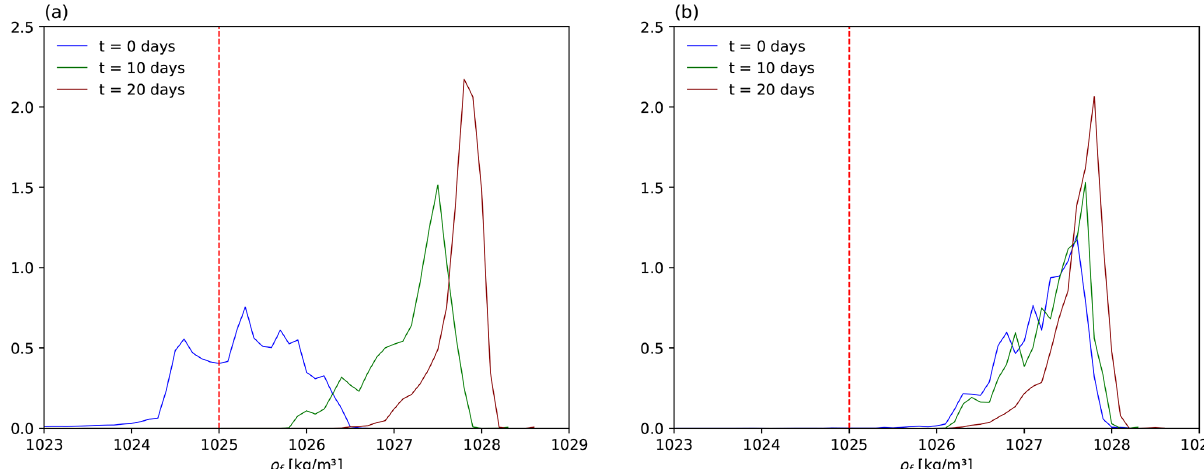
Figure 3. Normalized histogram of the seawater density ρ f at the positions of N = 78803 particles after t = 0, 10, and 20d of being released over the whole Mediterranean. (a) Summer release (release date 8 July 2000). (b) Winter release (release date 8 January 2000). The particles’ density is fixed at ρ p = 1041 . 5kg/m 3 , and fluid density is obtained from the TEOS-10 equations. The vertical line indicates a conventional seawater density of 1025kg/m 3 .